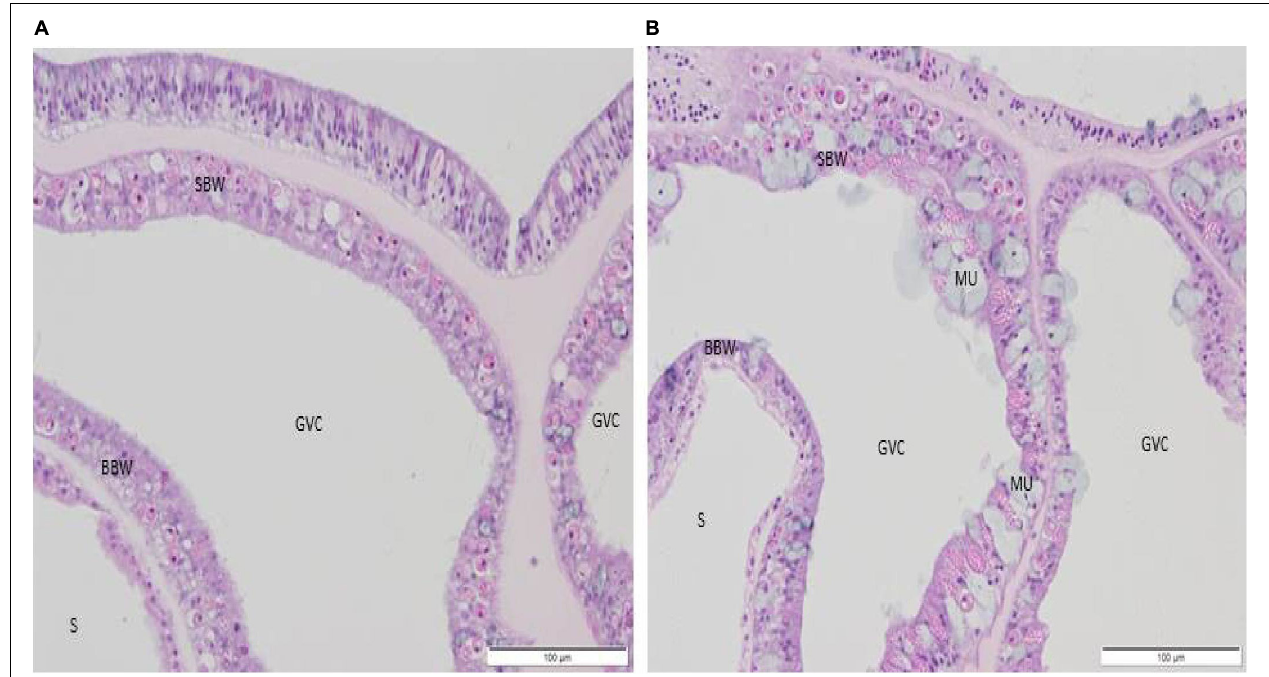
FIGURE 7 | (A,B) Histological sagittal section of the coenenchyme in a control recipient fragment showing absence of lesions (H&E). (A) M. cavernosa , 17 days post experimental start. (B) O. faveolata , 9 days post experimental start. BBW, basal body wall; GVC, gastrovascular canal; MU, mucocyte; SBW, surface body wall; S,